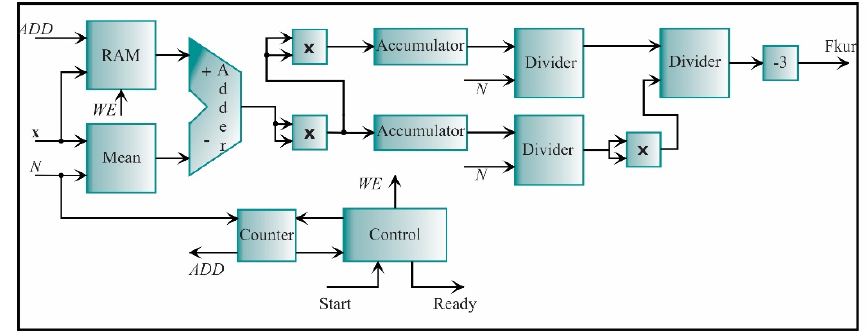
Figure 17. The architecture of the processing core for computing the kurtosis.